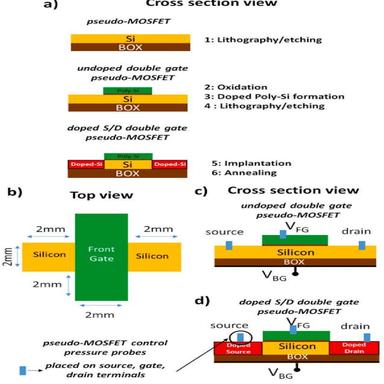
a) Scheme of the fabrication of the double-gate pseudo-MOSFET. Schematic of the test structure b) top view c) cross-section view of the undoped device d) cross-sectional view of the doped structure.